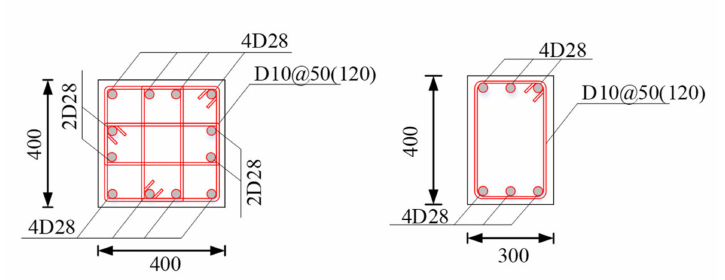
Figure 4. Reinforcement of precast beam and